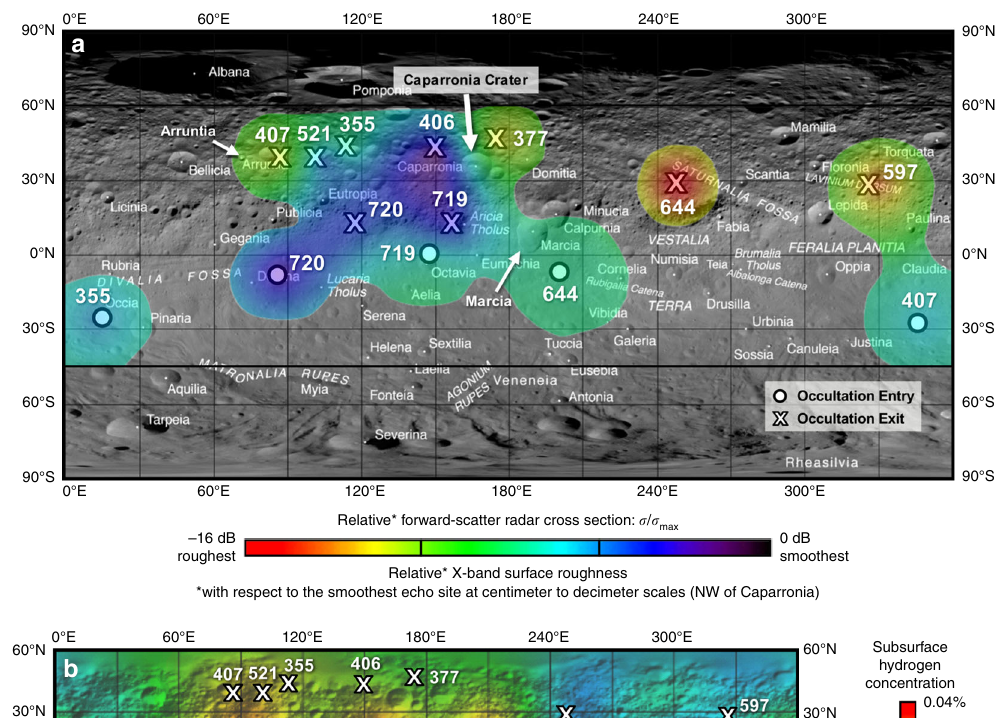
Relative* forward-scatter radar cross section: (cid:3) / (cid:3) max Relative* X-band surface roughness *with respect to the smoothest echo site at centimeter to decimeter scales (NW of